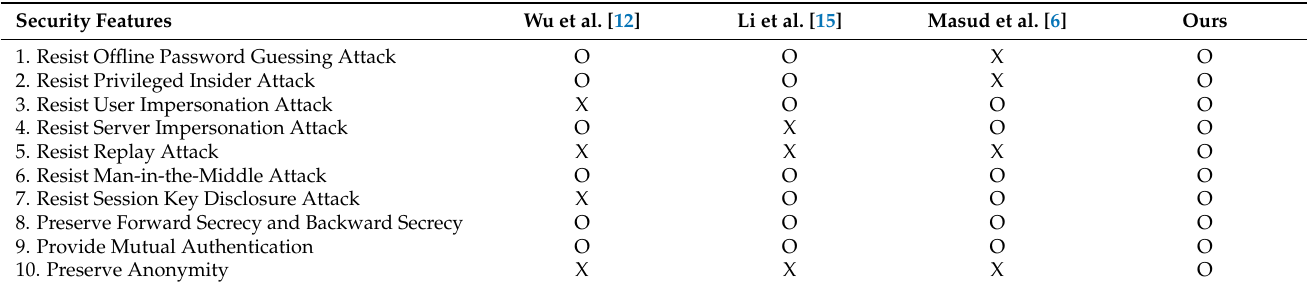
Table 11. Comparisons of the security features.